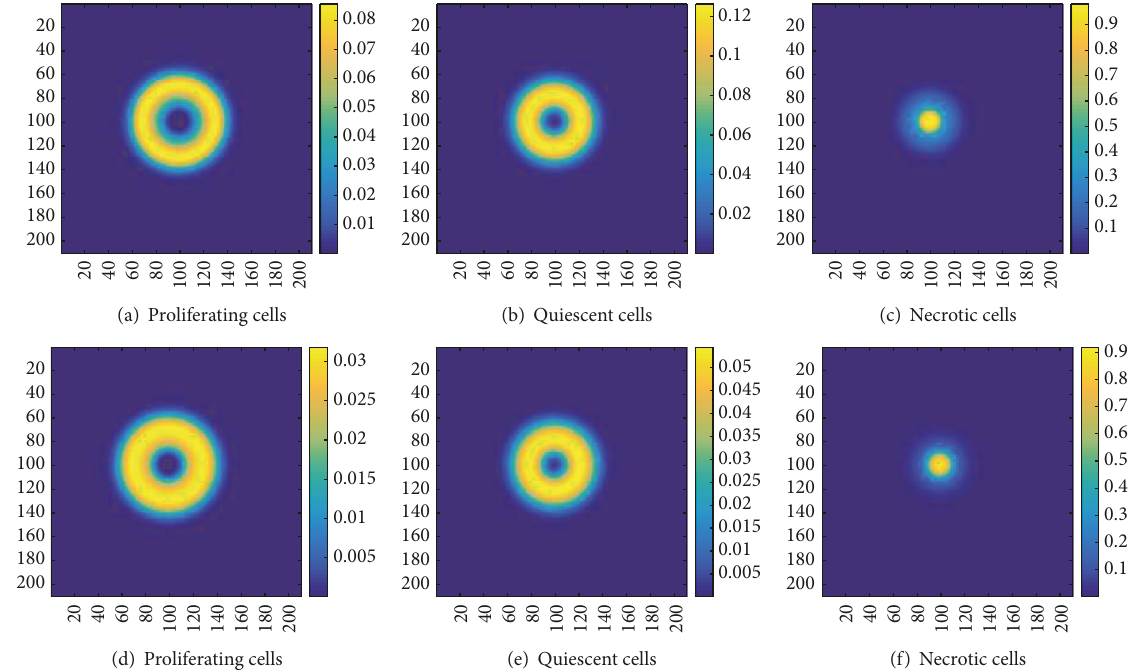
Figure 15: Heat map of cell densities at different oxygen degradation rates: the top row corresponds to the standard rate at 𝑘 1 = 0.15 ; the bottom row corresponds to a lower degradation rate at 𝑘 1 = 0.03 .